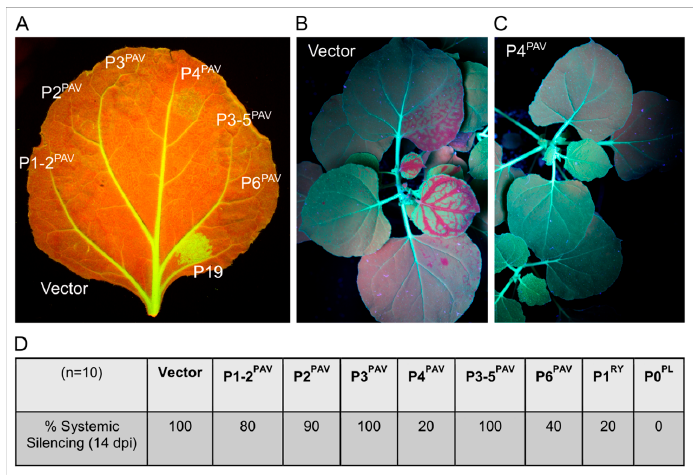
Figure 2. Local and systemic silencing suppression assays of luteovirus BYDV-PAV proteins. ( A ) Agro-infiltration of GFP-expressing N. benthamiana 16c leaves with sense GFP transgene plus BYDV-PAV proteins P1-2, P2, P3, P4, P3-5 or P6. The empty vector was used as a negative control for silencing suppression activity, while P19 from tomato bushy stunt virus (TBSV) was used as a positive control. Pictures were taken at 5 dpi under UV light. ( B ) Systemic silencing assay control. N. benthamiana 16c plants were agro-infiltrated with a sense GFP inducer plus the empty vector pBART. Picture of whole plants showing systemic silencing was taken at 14 dpi under UV light. ( C ) Systemic silencing assay for the BYDV-PAV P4 protein. N. benthamiana 16c plants were agro-infiltrated with a sense GFP inducer plus the P4 protein. Picture of whole plants showing no systemic silencing was taken at 14 dpi under UV light. ( D ) Scores of silencing suppression activity for the BYDV-PAV proteins P1-2, P2, P3, P4, P3-5 and P6. The P1 protein from RYMV and the P0 protein from PLRV were used as positive